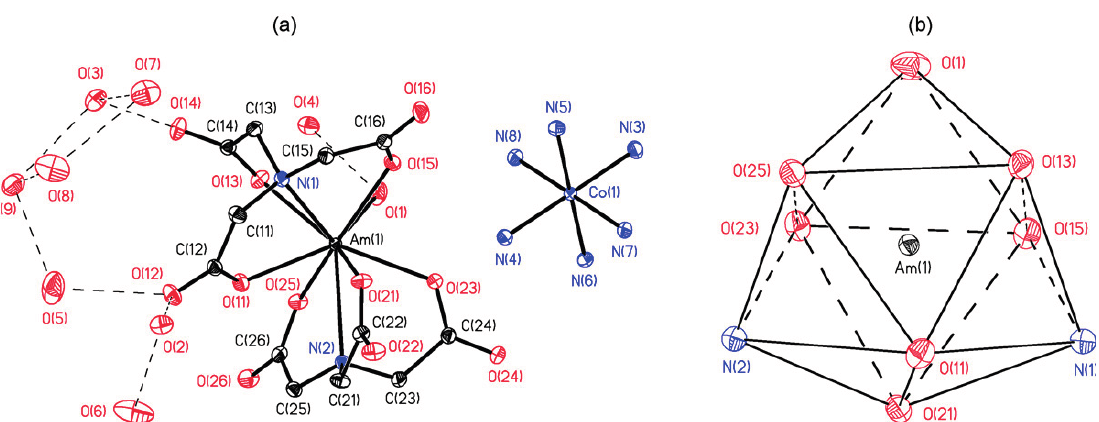
Figure 6. ( a ) ORTEP representation of [Co(NH ellipsoids are drawn at the 50% probability level, H atoms and coordination water molecules omitted for clarity; ( b ) coordination polyhedra of Am atoms.